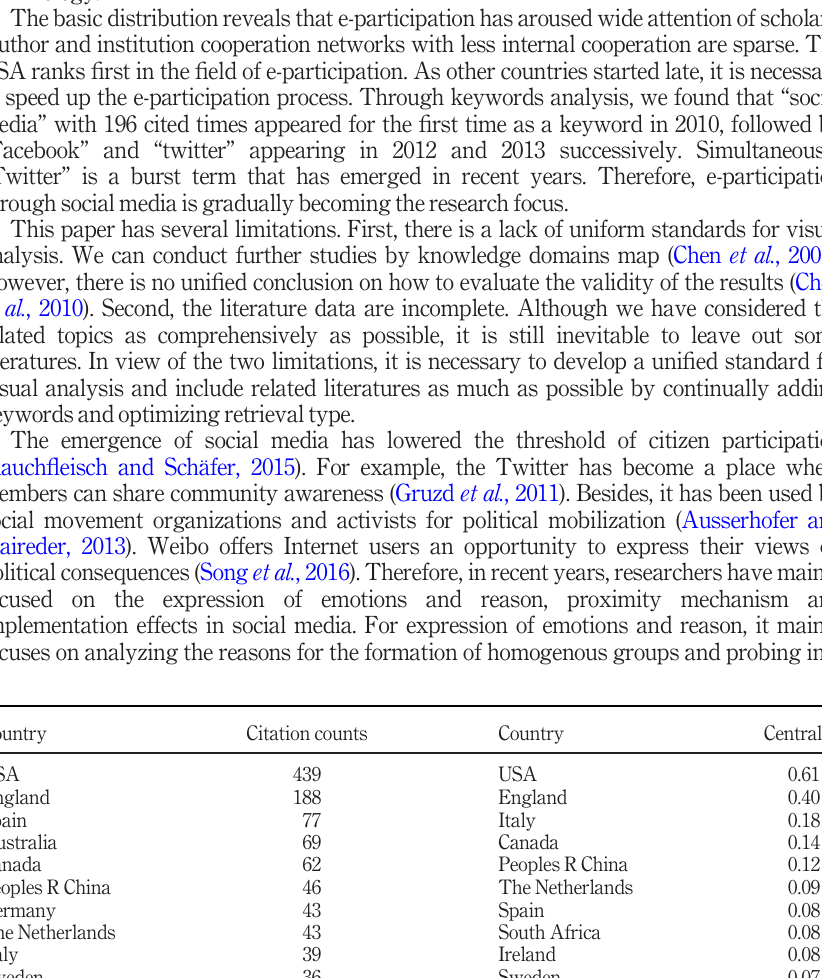
Table V. The top ten countries with the largest citation counts and centrality in e-participation